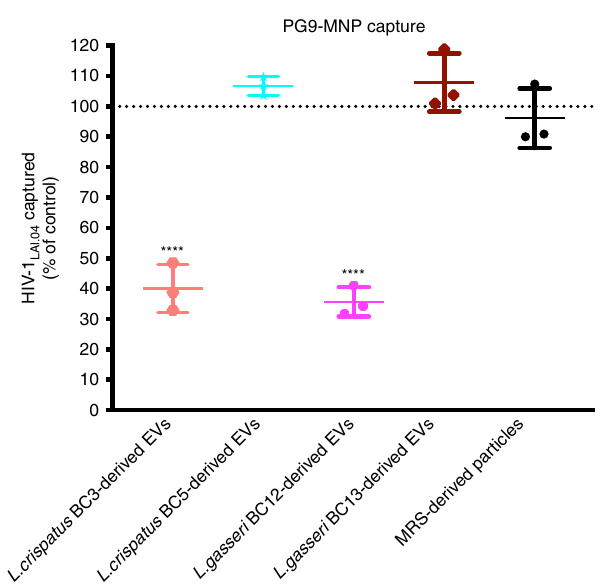
Fig. 6 Effect of Lactobacillus -derived EVs on HIV-1 viral envelope. HIV-1 LAI.04 virions were pretreated with EVs derived from each of four Lactobacillus strains ( L. crispatus BC3, L. crispatus BC5, L. gasseri BC12, L. gasseri BC13) or particles derived from MRS medium, or PBS (control)